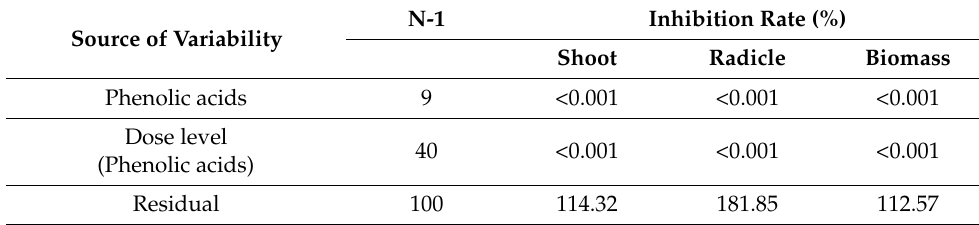
Table 2. Analysis of variance of variables measured in